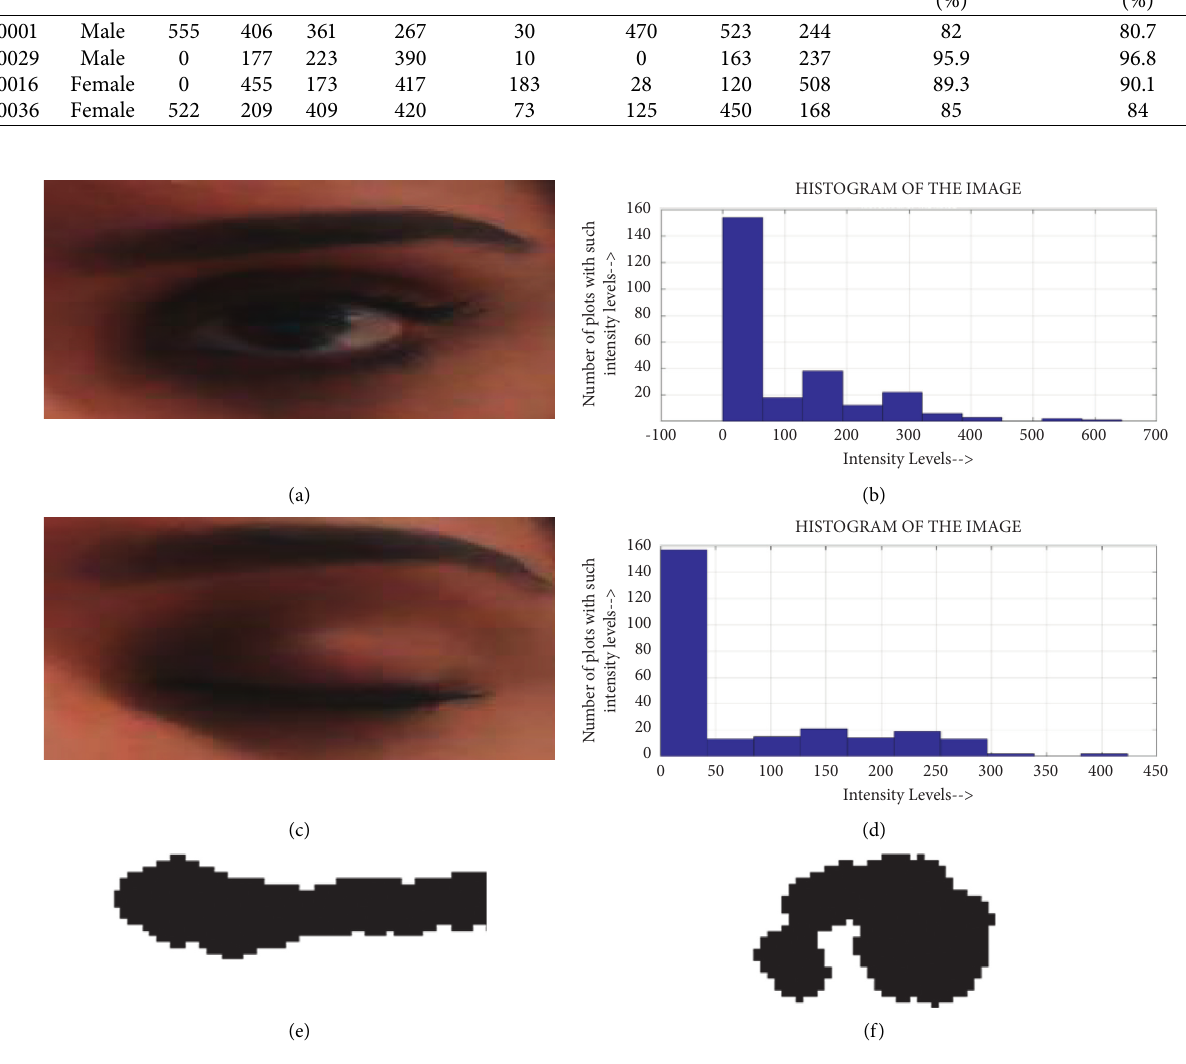
Figure 14: Results of implementation. (a) Sample of open eye. (b) Open eye sample flat structuring element. (c) Histogram of open eye. (d) Histogram of close eye. (e) Open eye sample flat structuring element. (f) Sample of close